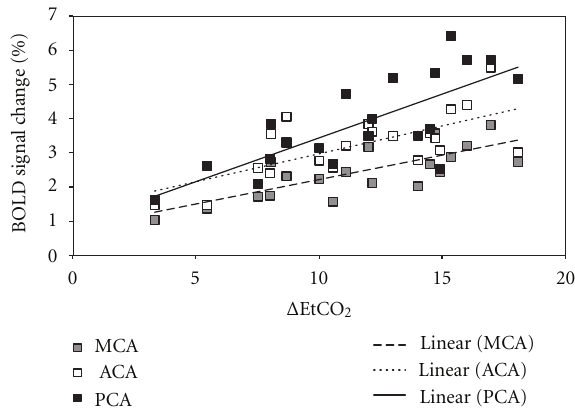
Figure 1: Linear correlation between BOLD signal change and Δ EtCO 2 in brain regions supplied by the three main cerebral arteries (anterior: ACA, middle: MCA, and posterior: PCA), for a group of healthy subjects who underwent CO 2 inhalation ( r 2 = 0 . 73 ± 0 . 04) . Note that the highest increases in BOLD signal were observed in region areas supplies by the posterior cerebral artery (PCA: black squares), and that the lowest BOLD signal amplitudes were observed in areas supplied by the middle cerebral artery (MCA: gray